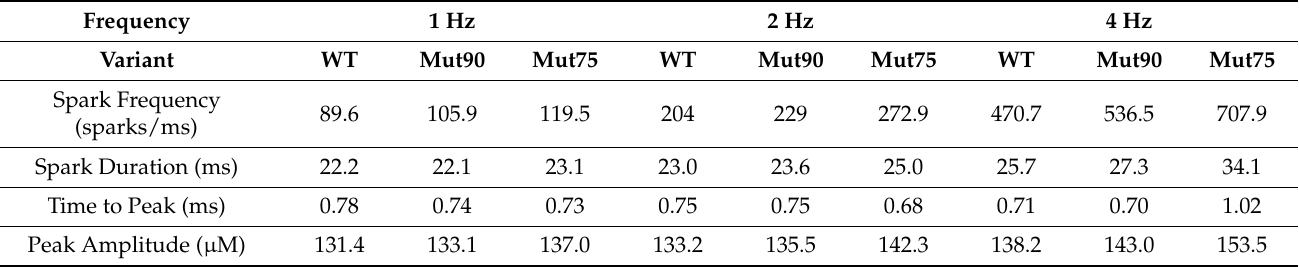
Table 3. Ca 2+ spark properties for mutations in CaM at different pacing